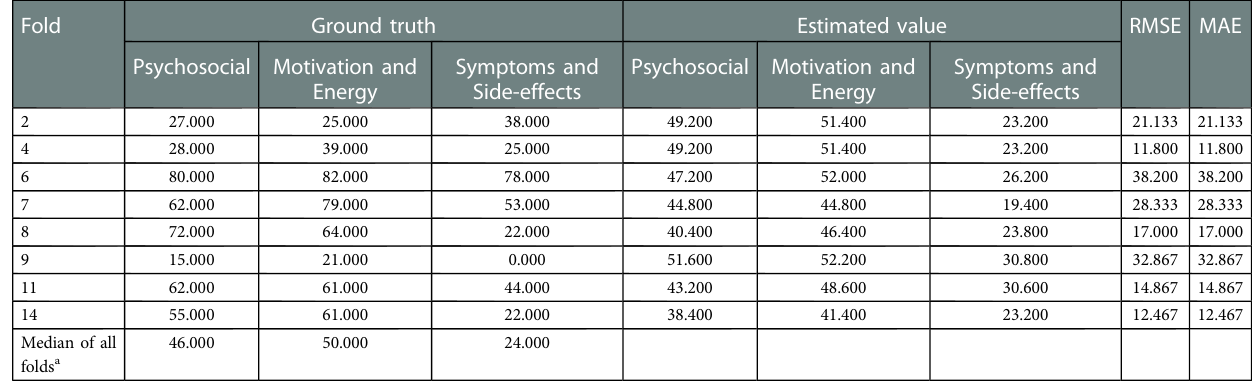
Table 7 Ground truth and estimated values for each subject with RMSE above